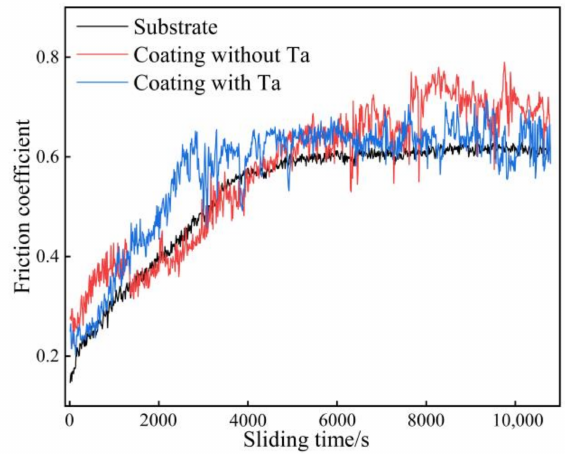
Figure 7. The relationship between friction coefficient and sliding time of the substrate and the coatings in neutral